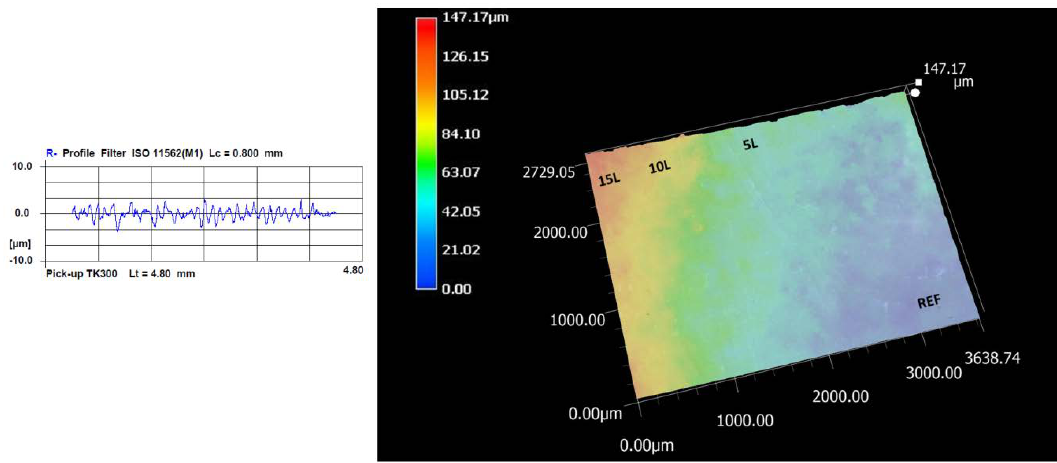
Figure 10. Two-dimensional roughness profile ( left ) and the 3D surface structure ( right ) for the sample 15L.